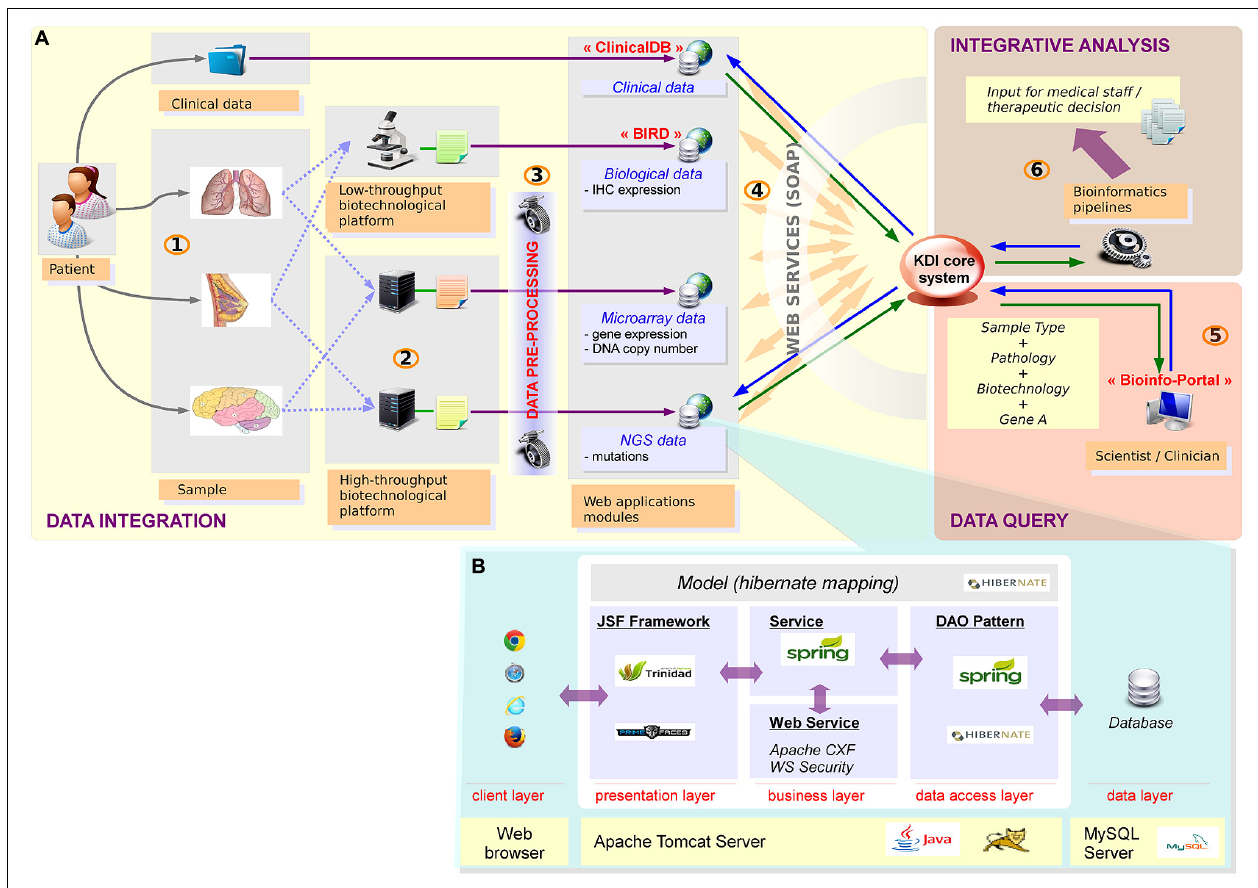
in dedicated applications. (4) Sample data and the corresponding patient are referenced in the KDI core system. (5) Advanced research functionality enable multiple data queries. (6) Specific bioinformatics pipelines generate new integrative knowledge from heterogeneous sources of data. (B) Technical view of web applications: web applications are based on n-tiers architecture, developed with J2EE